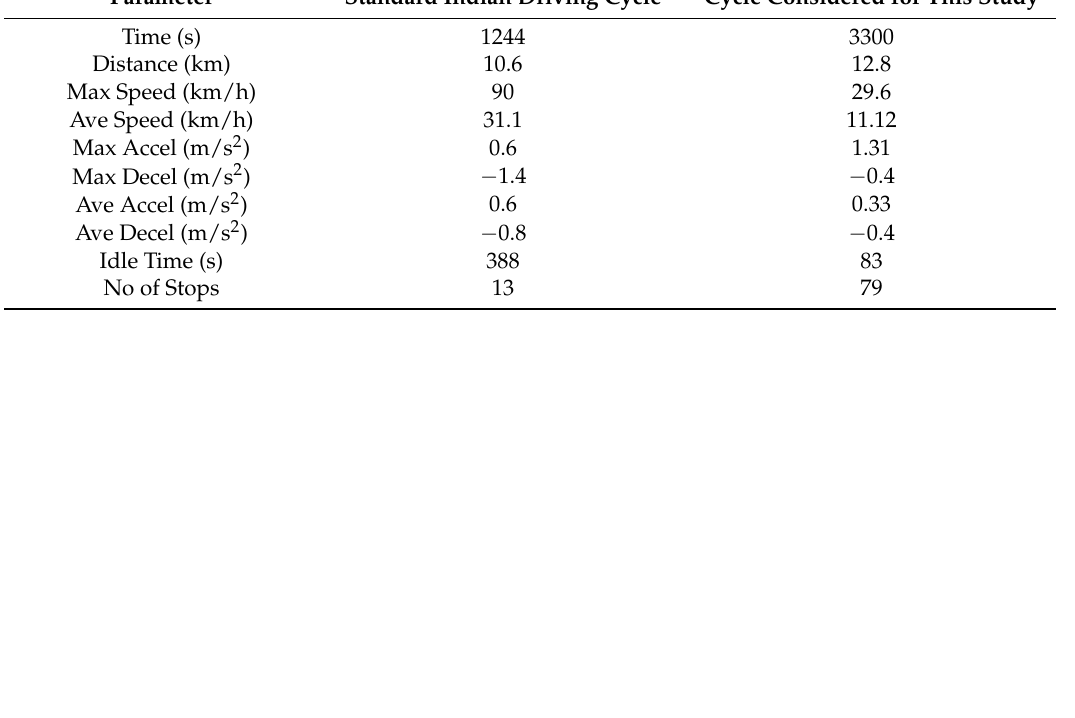
Table 2. Comparison of standard driving cycle and driving cycle considered for this study. Parameter Standard Indian Driving Cycle Cycle Considered for This Study